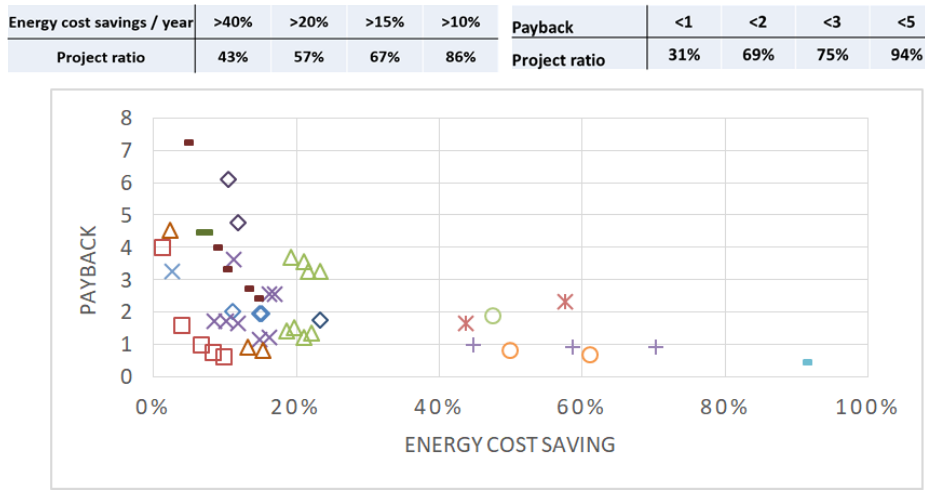
Fig. 20. – Savings vs. pay back from projects optimised with Hysopt software. minimal adjustments in the hydraulic system configuration and the control strategy provide savings up to 20% without requiring capital expense.